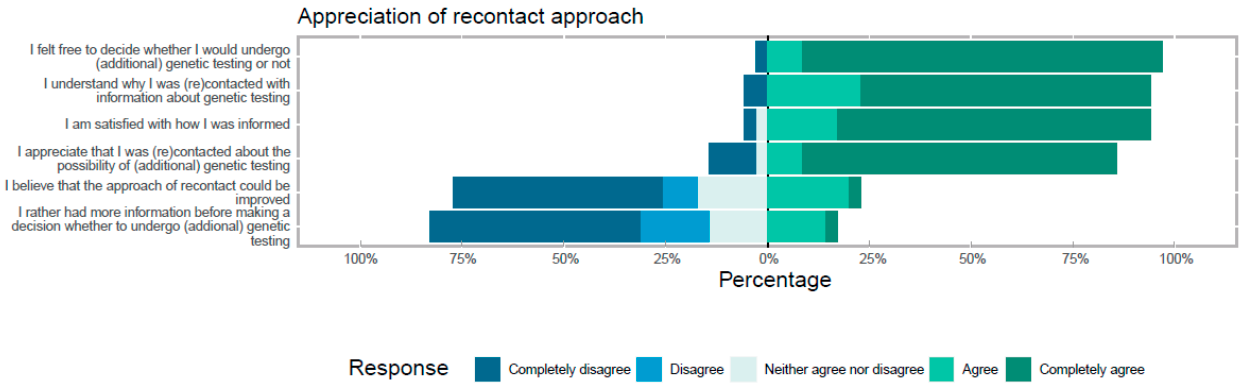
Figure 3. Patients’ experiences of the re-contact approach. All responses are shown in percentages and divided in subcat- egories.